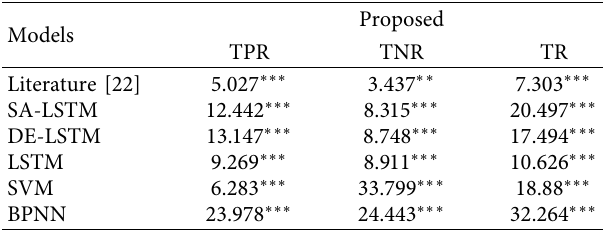
Figure 8: Comparison of prediction results. Table 3: Paired samples t -test for prediction accuracy of each model.